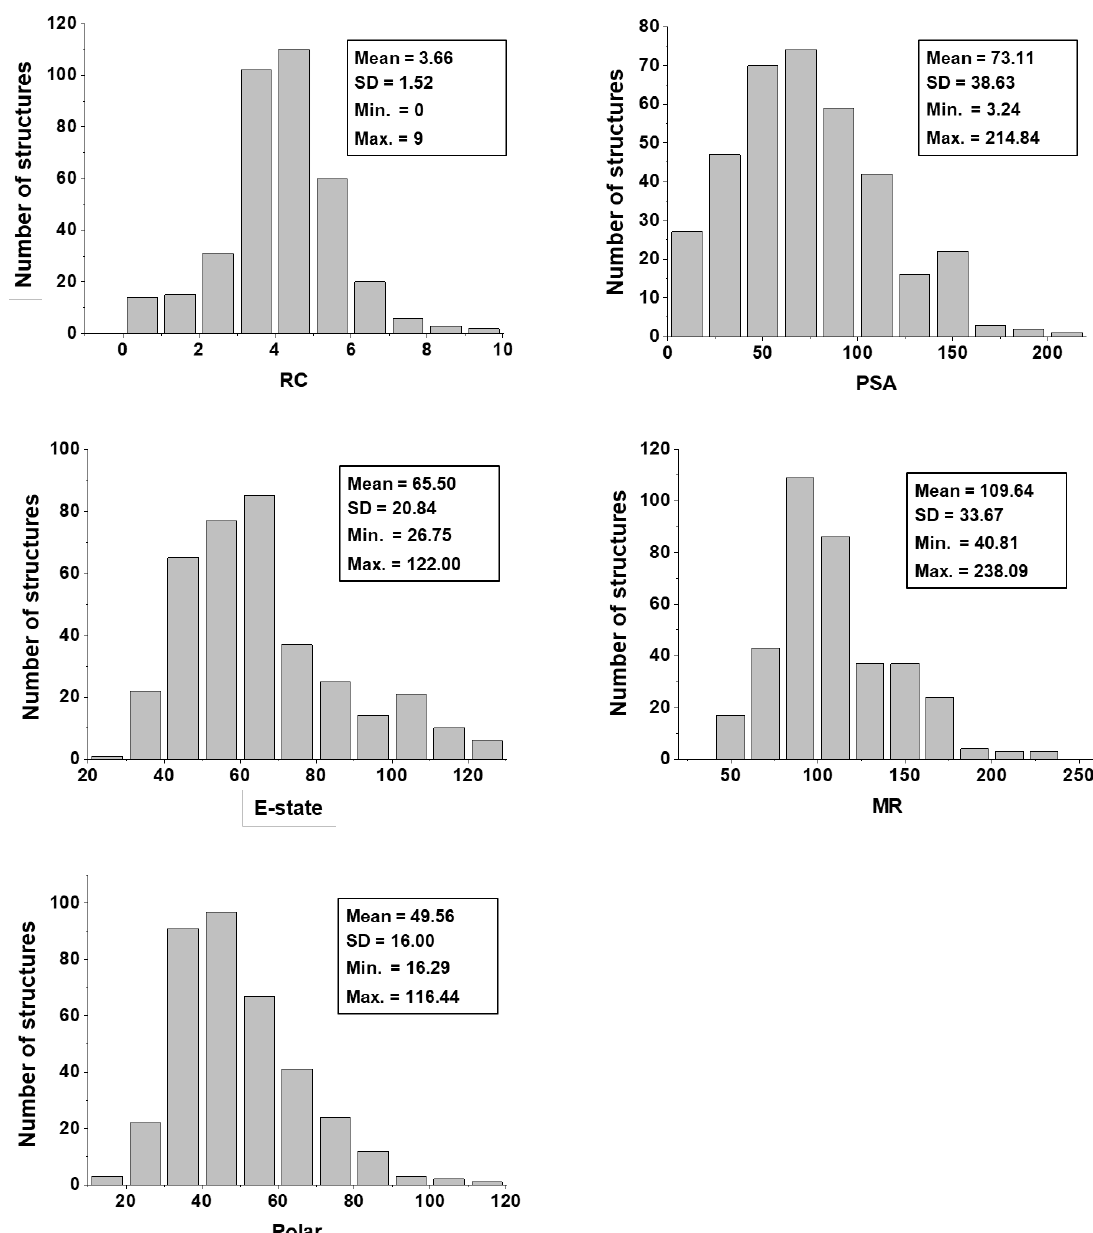
Figure 4. Physicochemical characterization of the dataset. Note: RC = ring count; PSA = polar surface area; E-state = electrotopological state; MR = molar refractivity; Polar = molecular polarizability; SD = standard deviation.